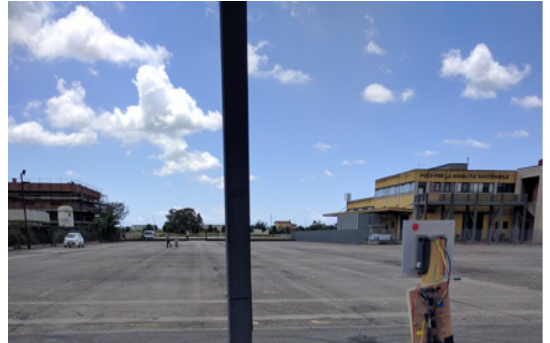
Figure 13. Experimental setup, Pole